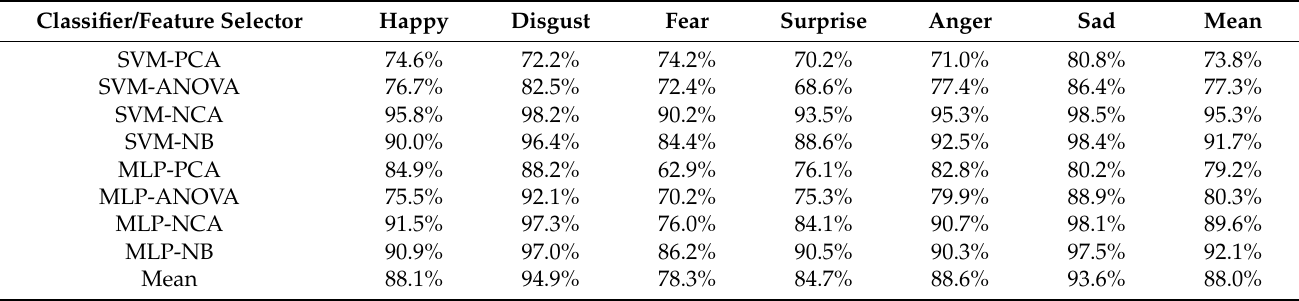
Table 1. Mean accuracy results for a ff ective state recognition based on six main ROIs reported from the implementation of SVM and MLP classi fi ers with PCA, ANOVA, NCA, and NB feature selection algorithms.